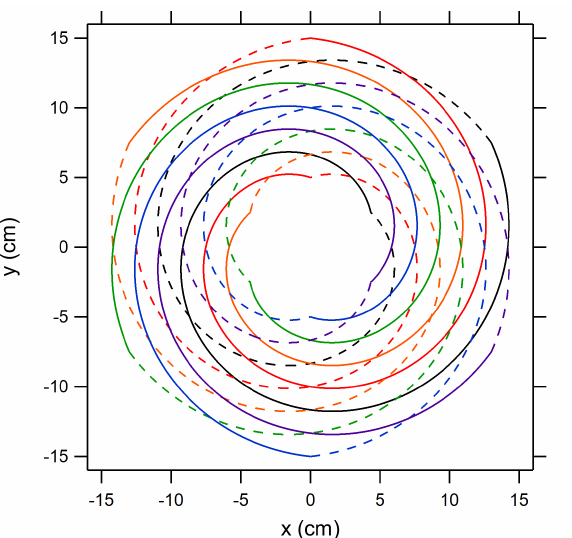
Figure 27. Illustration of a two-turn Archimedes spiral coil with six parallel leads clocked at 60 ◦ intervals, indicated by the colors red, orange, green, blue, purple, black. Each lead completes one outward counter-clockwise spiral on the front surface (solid line) and then one inward counter-clockwise spiral on the back surface (dashed line) to return to the initial starting